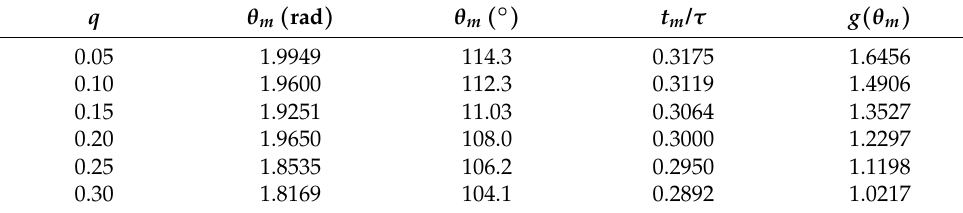
Figure 7. Forced resonant oscillations of a linear damped oscillator as a function of dimensionless time θ ≡ ˜ ω t where the applied frequency ω is equal to the oscillation frequency ˜ ω , that is, ω = ˜ ω . The plots are obtained for α = 0. The forcing decays exponentially with time at the same rate as the free wave damping. The phases are matched to lead to oscillations that initially increase with time, ultimately decaying to damping, and even sooner for stronger damping. Table 1. Resonant forcing with exponential time decay. The results are obtained for α =